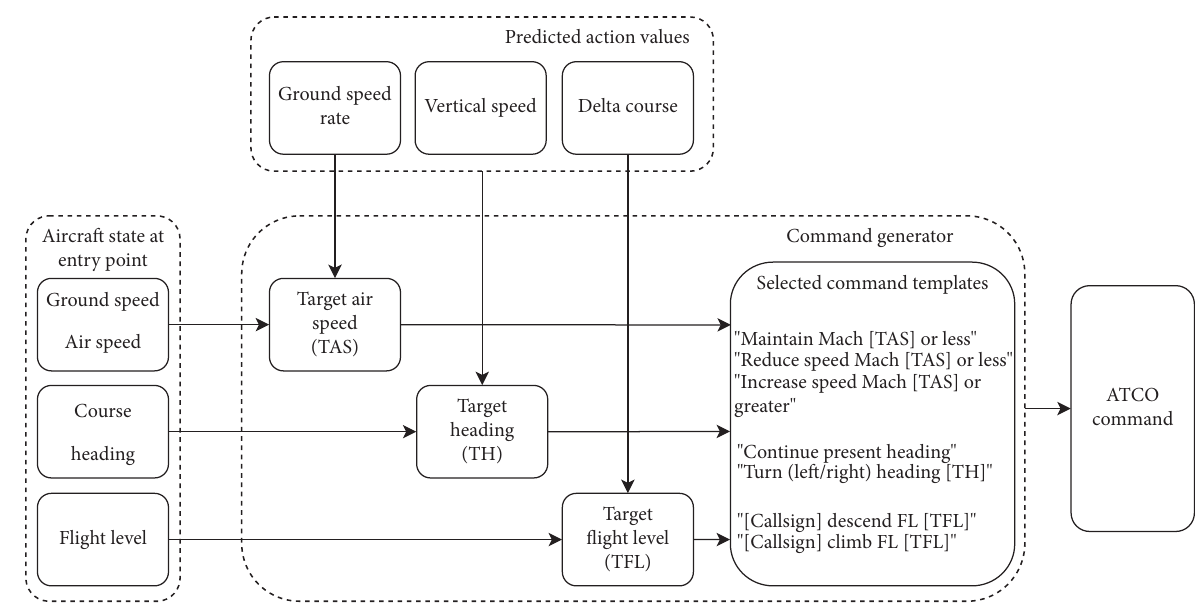
Figure 17: The flow diagram for converting from predicted results into ATCO’s